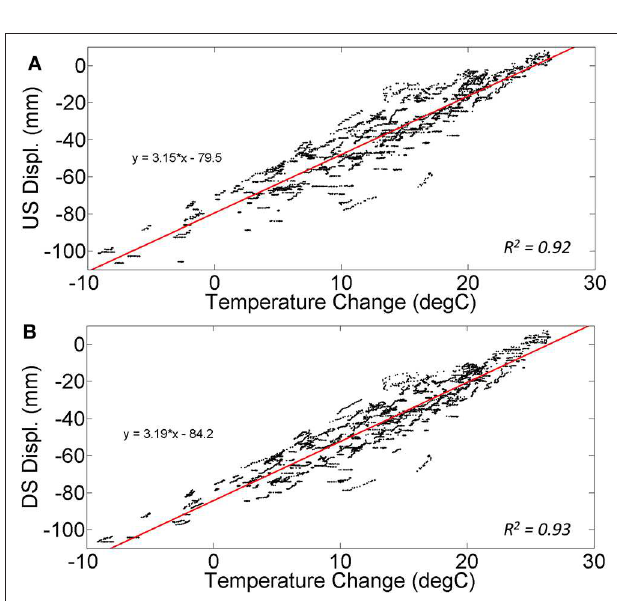
FIGURE 11 | Displacement vs. temperature relationship over 10 months at (A) Pier A upstream and (B) Pier A downstream.